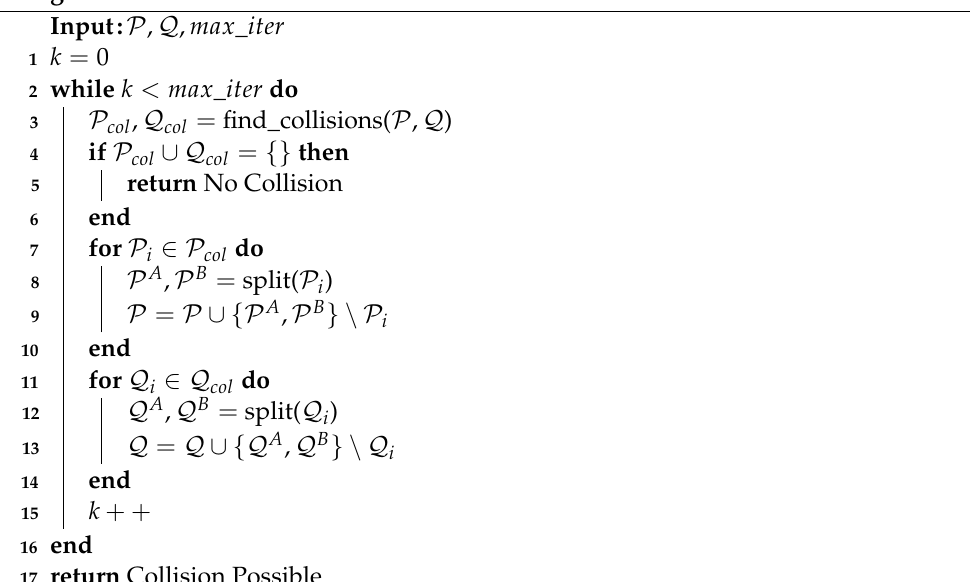
Algorithm 3: Collision